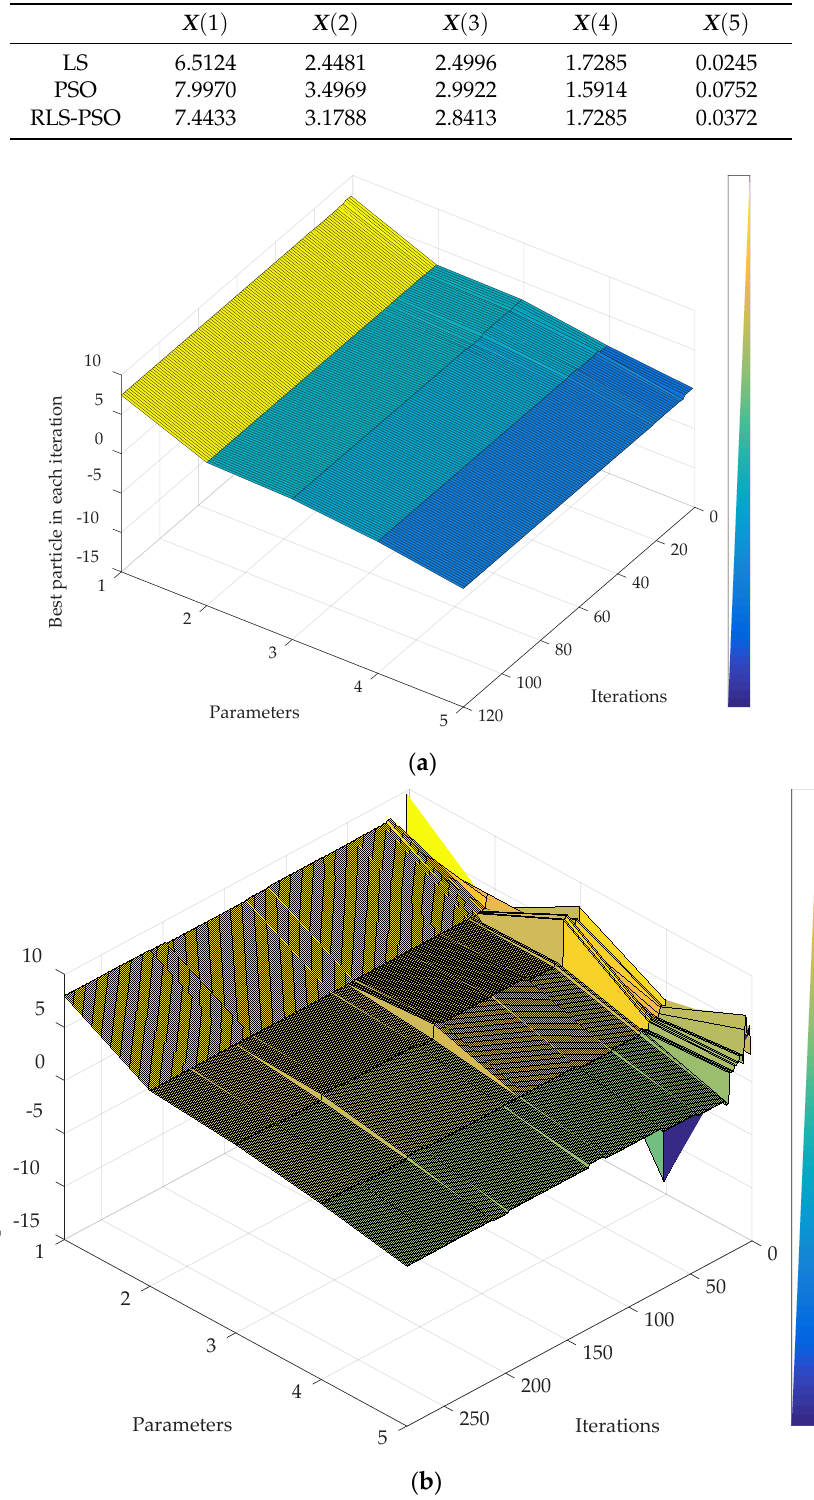
Figure 11. The convergences of X(1:5) in PSO and RLS-PSO: ( a ) The convergence of best particle in